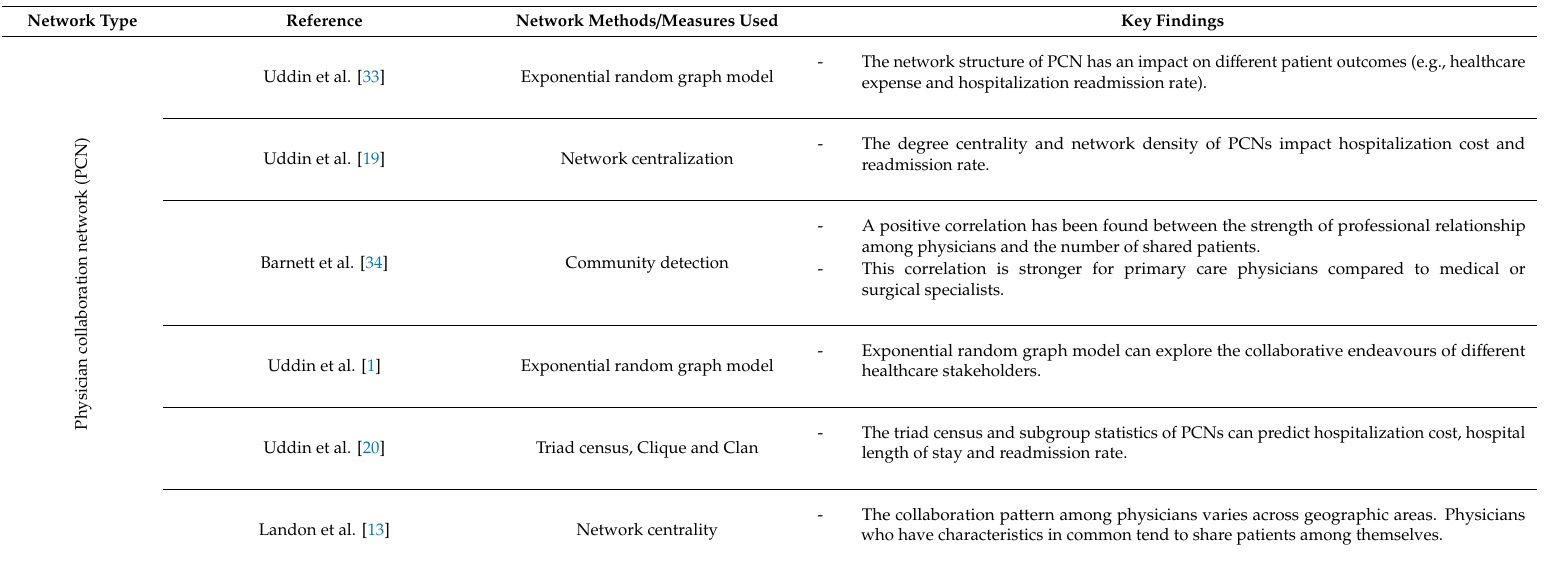
Table 3. Characteristics (i.e., network methods followed and key findings) of the included network